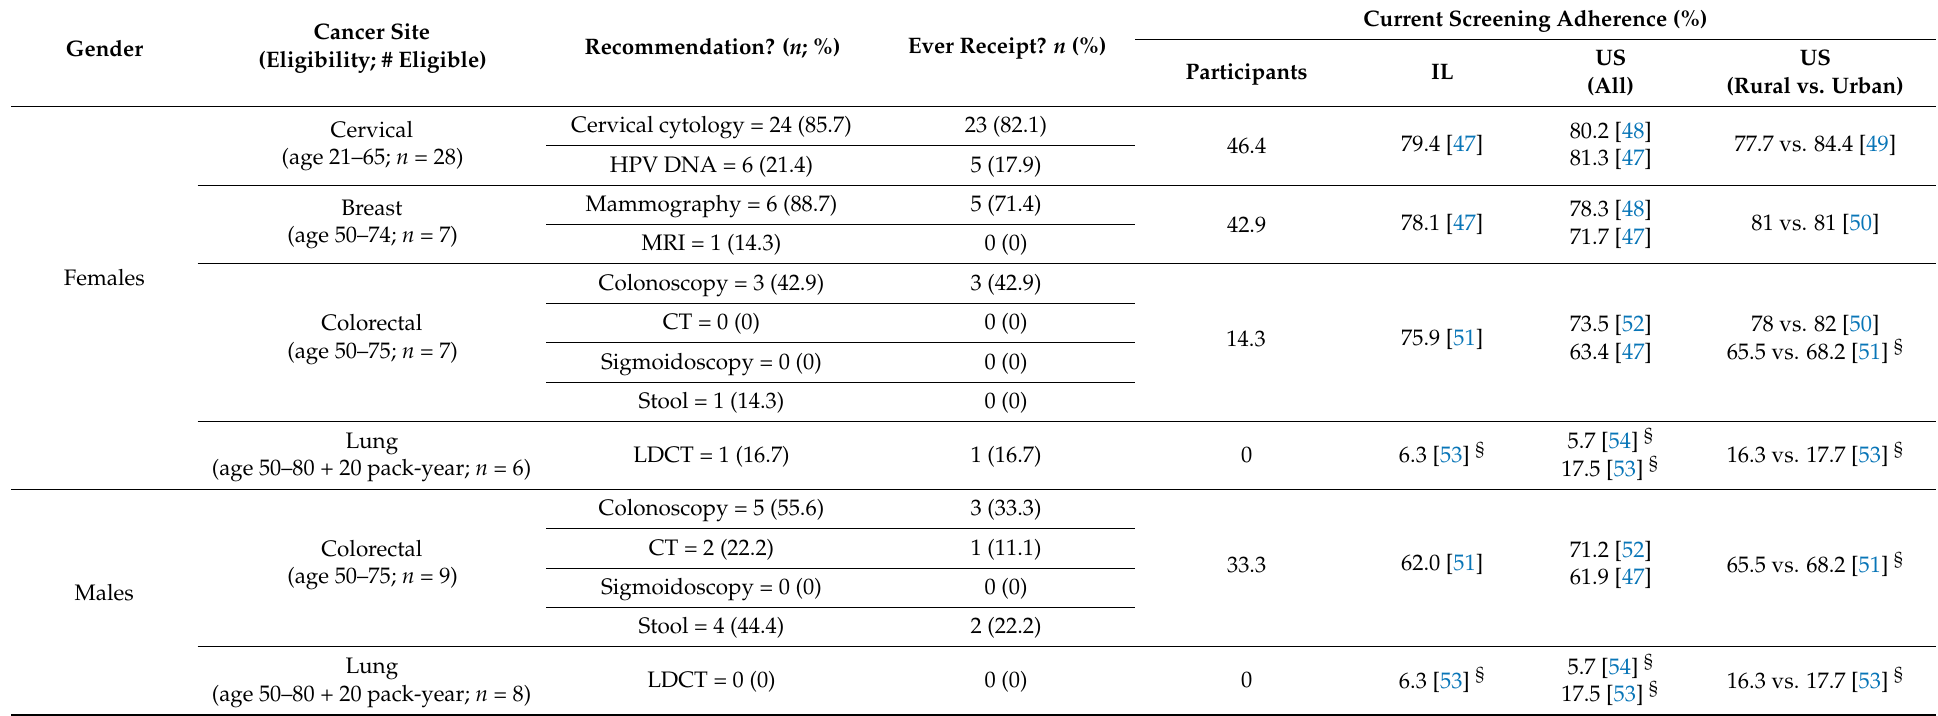
Table 2. Reported receipt of screening recommendation, specific cancer screening, and current screening status (adherent versus past due; with comparison to IL and US adherent